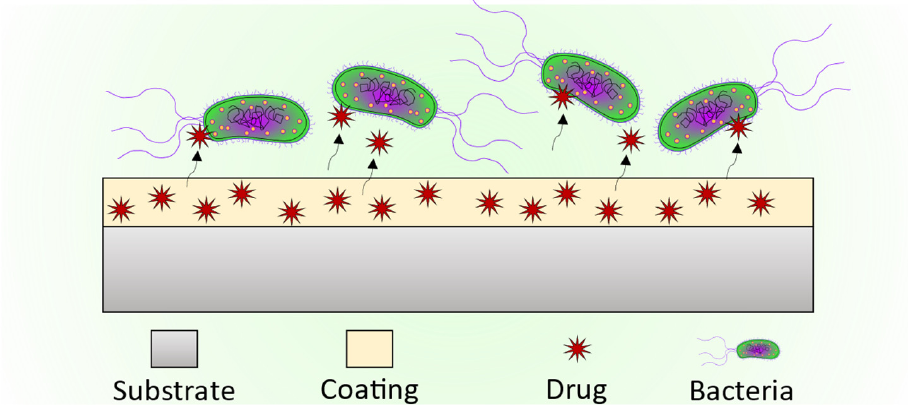
Figure 7. Schematics of a sol-gel coating loaded with an antibiotic drug. Figure 6. Schematics of a sol-gel coating preventing the corrosion of a metallic substrate by acting as a physical barrier against aggressive elements.